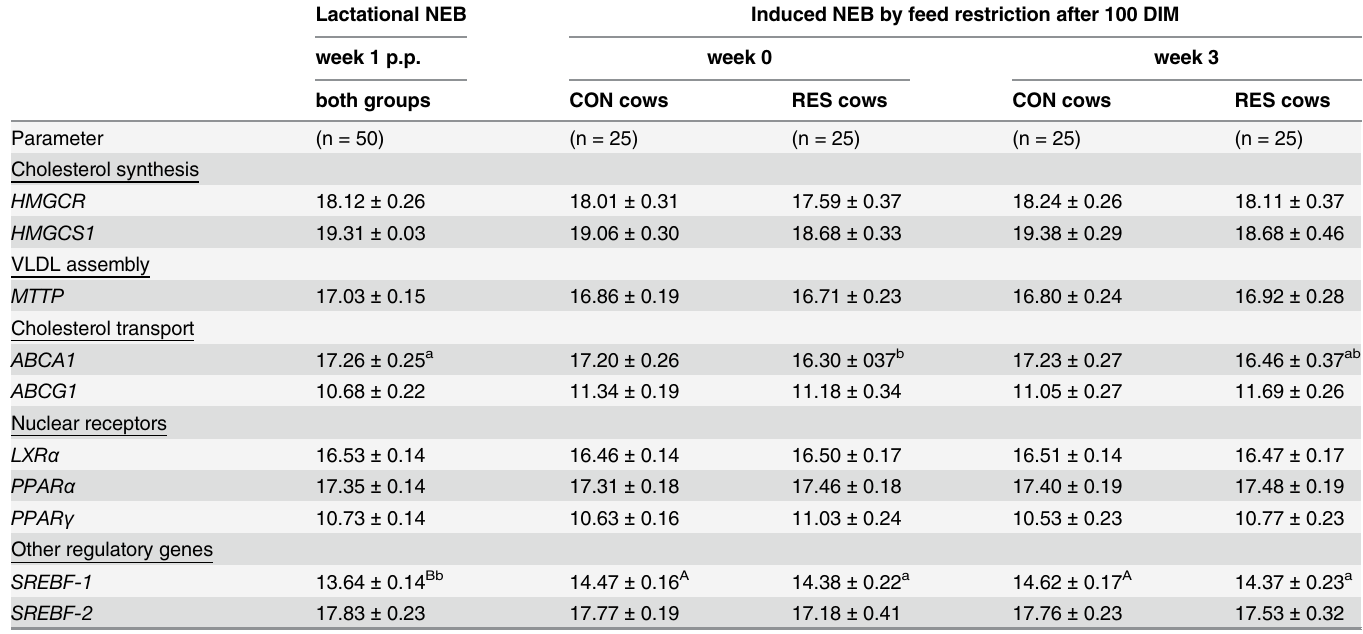
Table 2. Relative mRNA abundances (delta CT, log 2 ) of genes analyzed in liver biopsies in week 1 p.p., and before (week 0) and after (week 3) feed restriction in